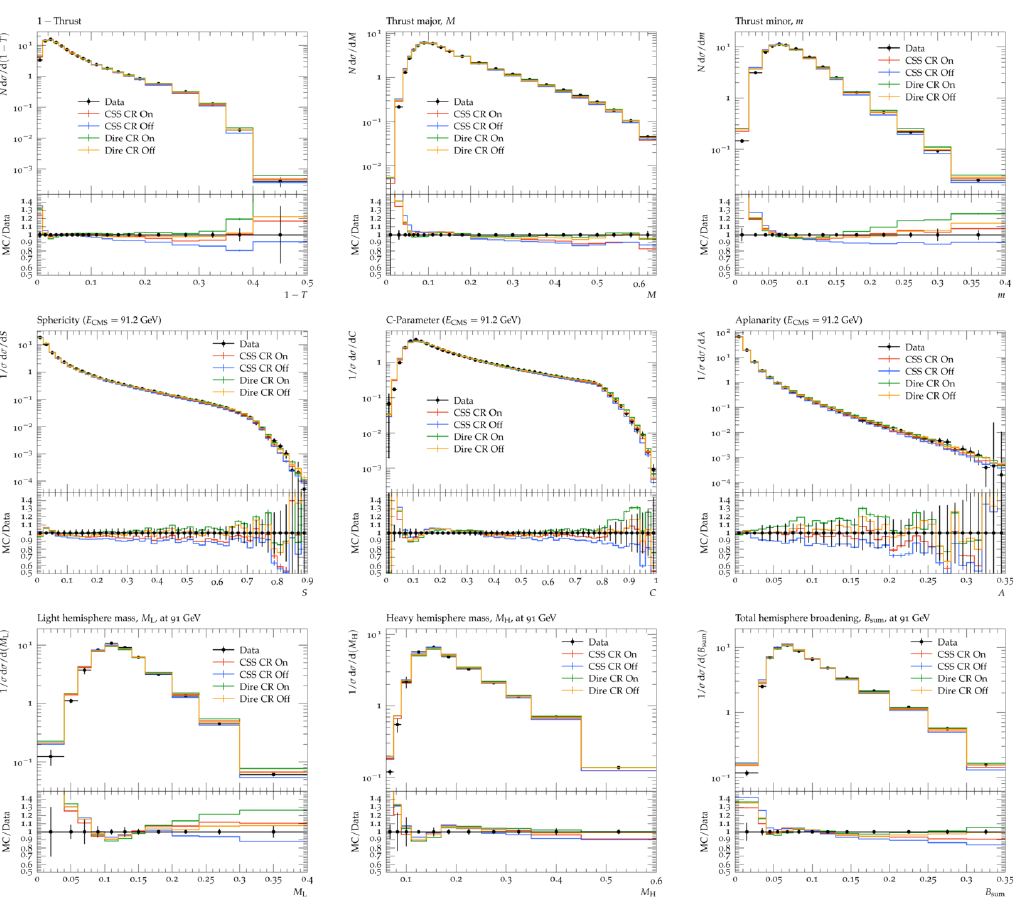
Figure 5: Various event shapes distributions in e − e + → hadrons at centre-of-mass energies of 91.2 GeV. Upper row, from left to right: thrust, thrust major, thrust minor, all from D ELPHI [ 47 ] ; middle row, from left to right: sphericity, C parameter and apla- narity, all from A LEPH [ 49 ] ; lower row, from left to right: light and heavy hemisphere mass and total hemisphere broadening, all from O PAL [ 50 ]